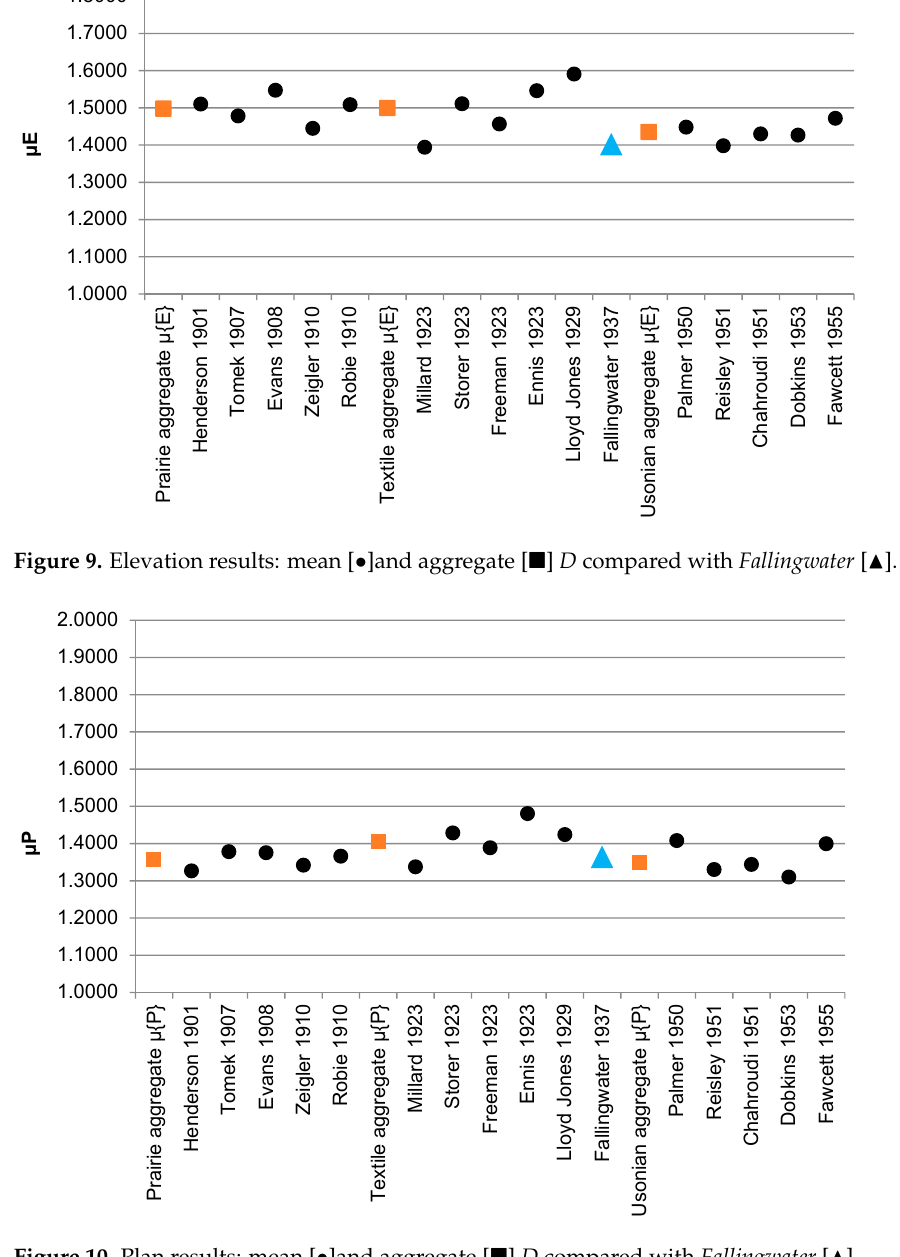
Figure 10. Plan results: mean [  ]and aggregate [  ] D compared with Fallingwater [  ].